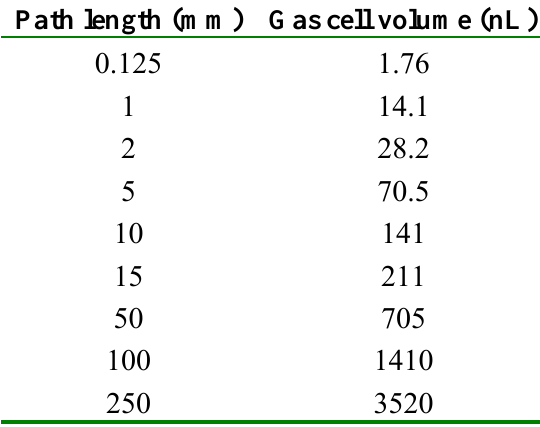
Table 2. Gas cell path lengths with their corresponding volumes at fixed bore size of 134